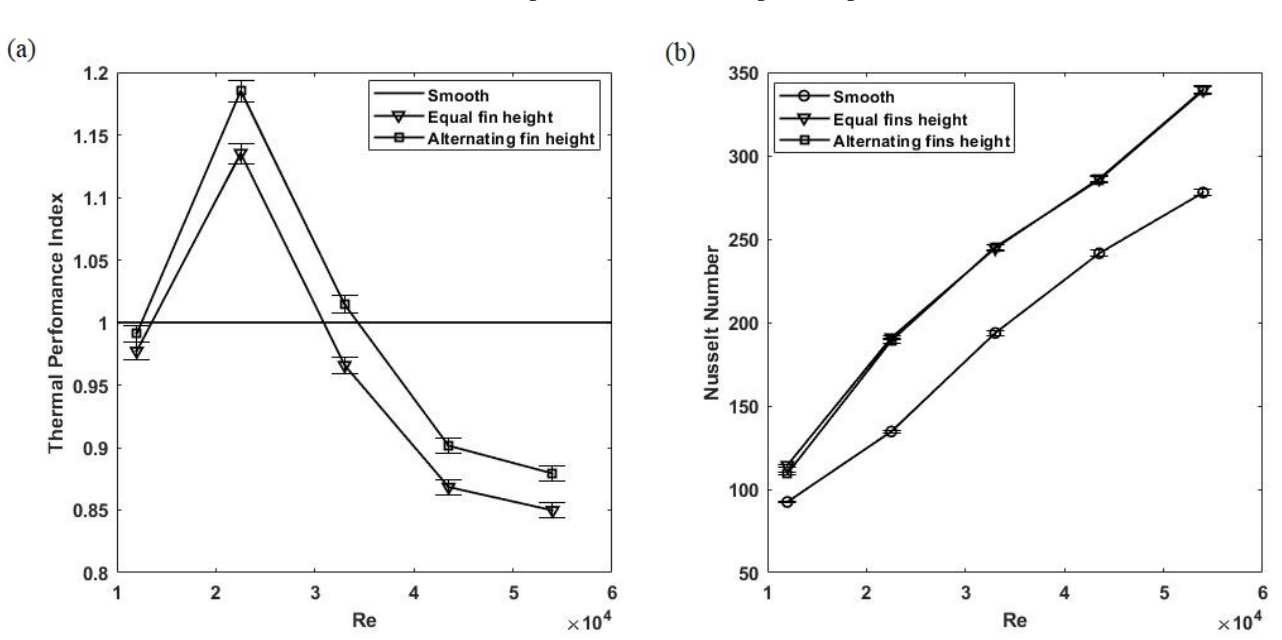
Figure 11. ( a ) Thermal performance index and ( b ) Nusselt number of the studied tubes. Figure 12 shows the normalized friction factor and heat transfer coefficient with respect to smooth for both micro-finned tubes. The normalization is done to analyse the relative performance of micro-finned tubes with respect to the smooth tube and each other.